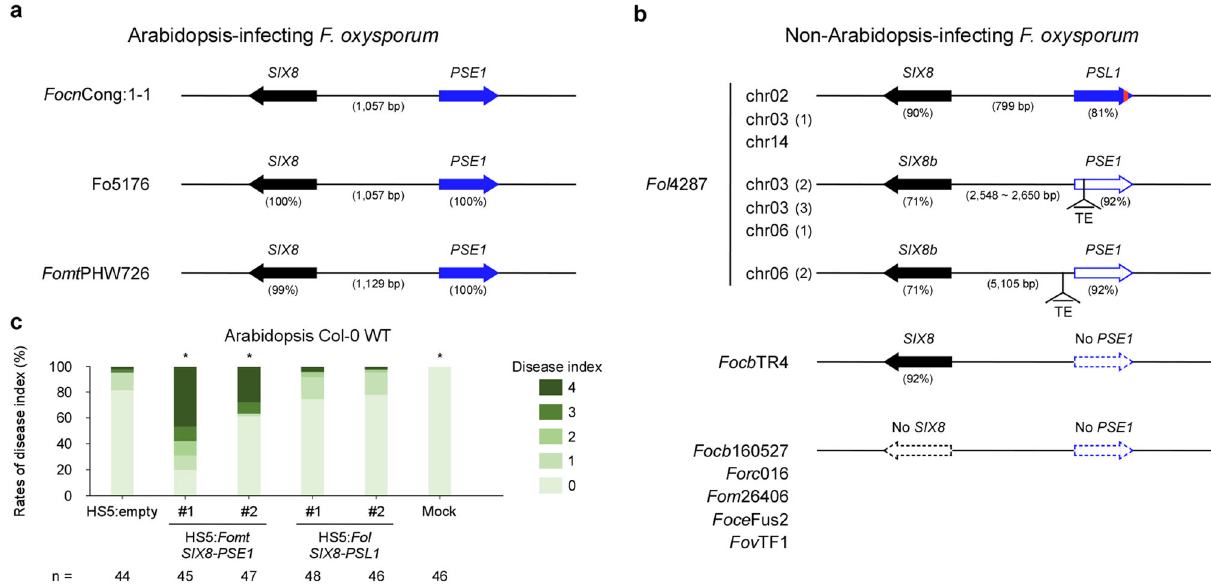
Fig. 6 Genetic and functional conservation of a pair of effectors, SIX8 and PSE1 , among F. oxysporum isolates. Comparison of the SIX8 - PSE1 loci in Arabidopsis-infecting ( a ) and non-Arabidopsis-infecting F. oxysporum isolates ( b ). A red region in the arrowhead of PSL1 indicates a region of 10 amino acids that differ from PSE1 . The amino acid level identity (%) to Focn Cong:1-1 SIX8 or PSE1 is shown in parentheses. Focn Cong:1-1, F. oxysporum f. sp. conglutinans Cong:1-1; Fomt PHW726, F. oxysporum f. sp. matthiolae PHW726; Fol 4287, F. oxysporum f. sp. lycopersici 4287; Focb TR4, F. oxysporum f. sp. cubense tropical race 4; Focb 160527, F. oxysporum f. sp. cubense 160527; Forc 016, F. oxysporum f. sp. radicis-cucumerinum 016; Fom 26406, F. oxysporum f. sp. melonis 26406; Foce Fus2, F. oxysporum f. sp. cepae Fus2; Fov TF1, Fusarium oxysporum f. sp. vasinfectum TF1. c Virulence of Focn Cong:1-1 HS5 transformants introduced with a hygromycin B resistance gene ( hph ) cassette (HS5:empty), the Fomt SIX8 - PSE1 locus (HS5: Fomt SIX8 - PSE1 ) and the Fol SIX8 - PSL1 locus (HS5: Fol SIX8 - PSL1 ) on Arabidopsis Col-0 WT. Disease index was scored as described in Methods. Results of six independent experiments were combined. n denotes the number of plants investigated. Asterisks represent signi fi cant difference from Focn Cong:1-1 HS5:empty. (* p < 0.01, Mann – Whitney U-test). Representative images of Arabidopsis at 28 dpi are shown in Supplementary Fig.